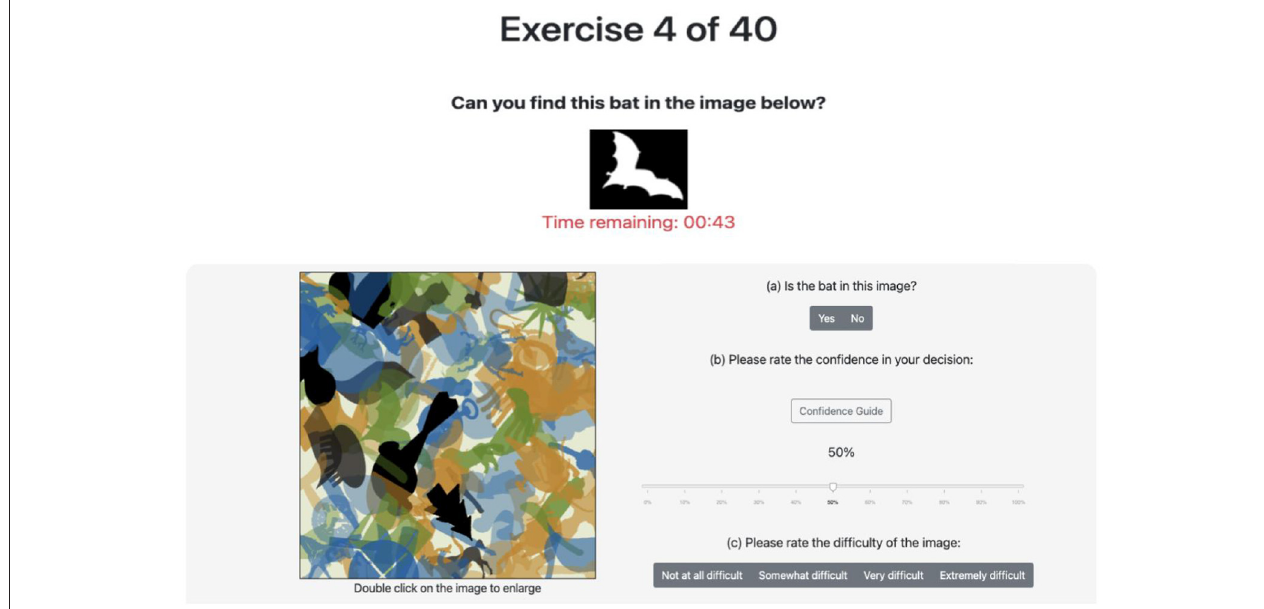
FIGURE 3 | Image classification task UI for imbalanced dataset—image contains bat (center left).